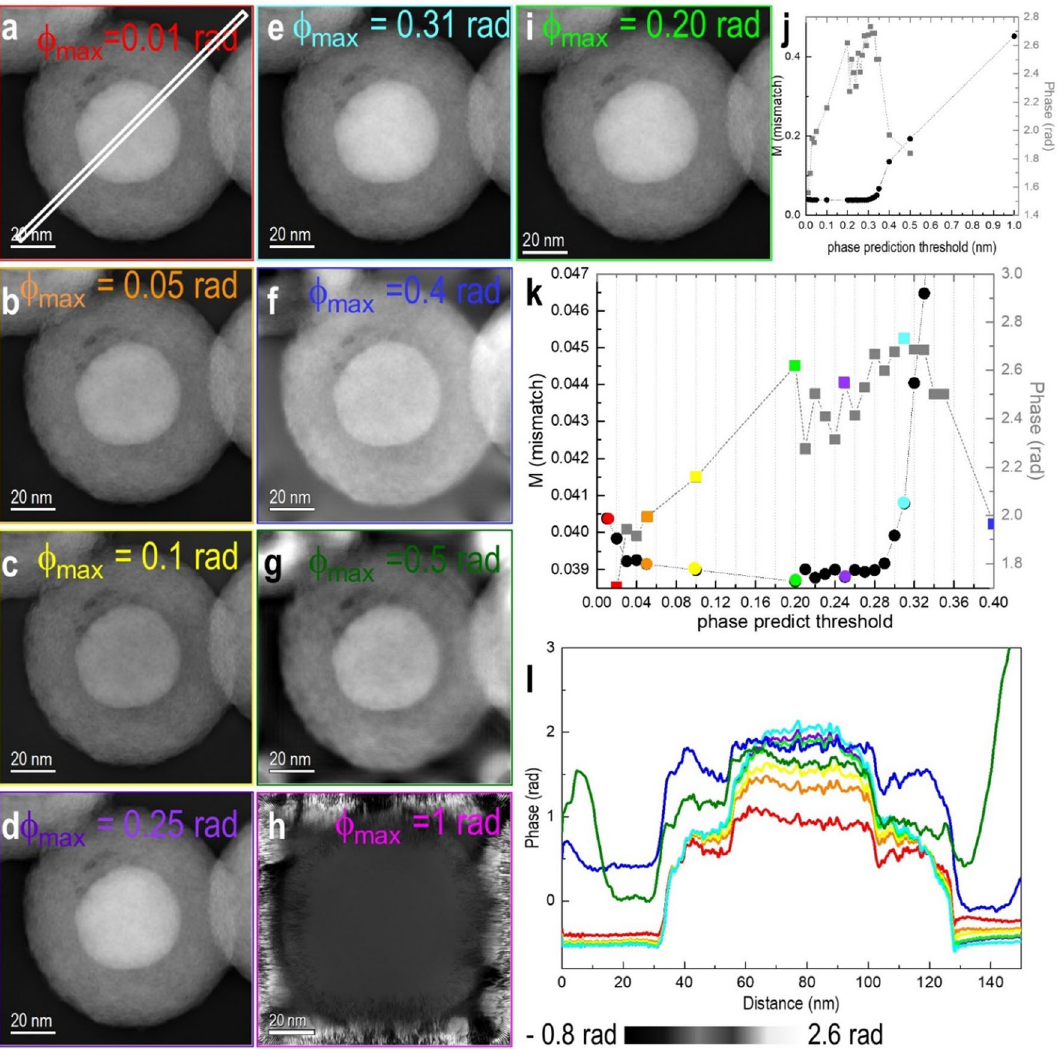
Figure 3. Phase images of Fe-filled C nanospheres reconstructed using phase prediction thresholds of ( a ) 0.01, ( b ) 0.05, ( c ) 0.1, ( d ) 0.25, ( e ) 0.31, ( f ) 0.4, ( g ) 0.5, ( h ) 1.0 and ( i ) 0.20 rad. ( j ) Phase prediction threshold vs M value (mismatch between simulated and experimental images) and phase contrast. ( k ) Magnified version of ( j ). ( l ) Line profiles extracted from the region marked in a) for phase images ( a ) to ( i ). The grey squares represent phase, and black circles are mismatch values M in ( j ) and ( k ) and colors represent the ϕ max that is presented with the